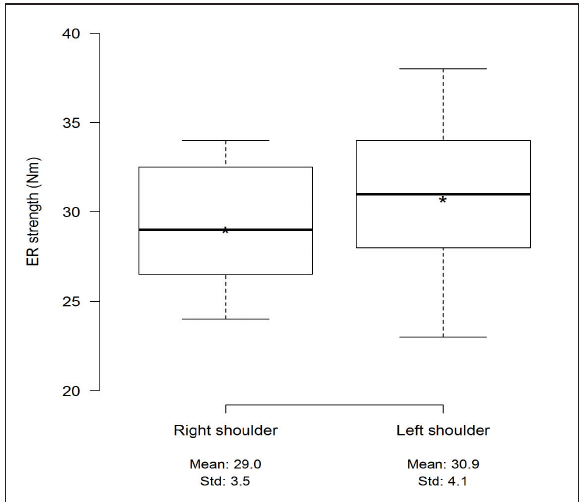
Figure 2 – Comparison between right and left shoulder ER strength in swimmers.